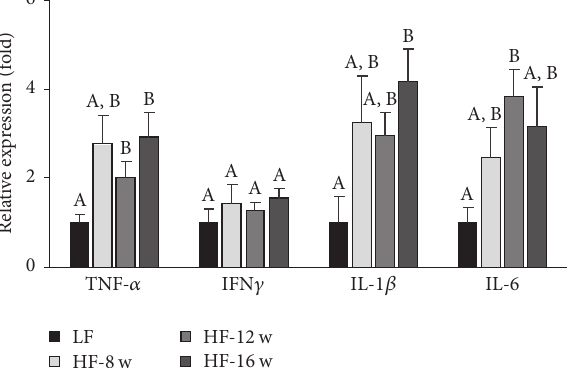
Figure 5: Effect of high fat diet consumption on the relative expression of inflammatory cytokines in the small intestinal epithelial cells. Among the 4 cytokines examined, except for IFN 𝛾 , the mRNA expressions of TNF- 𝛼 , IL-1 𝛽 , and IL-6 were significantly enhanced at least in one of the three HF groups when compared to the control group fed with a LF diet for 8